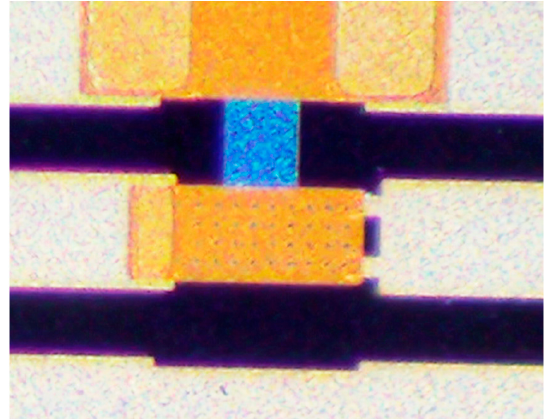
Figure 4. Optical photo of device.